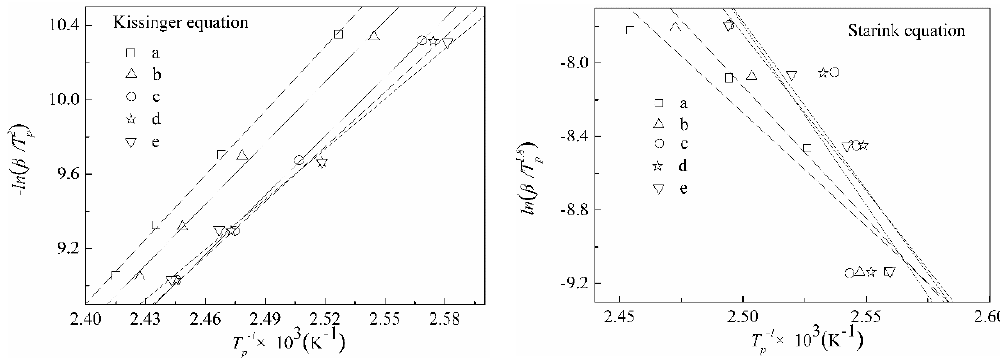
Figure 8. DSC curves of DCPRs (( a ) 0%; ( b ) 5%; ( c ) 10%; ( d ) 15%; ( e ) 20%).